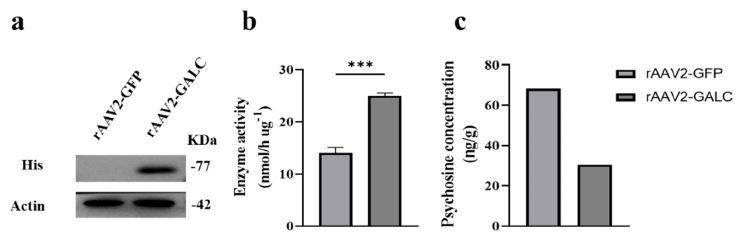
Figure 3. rAAV2-mediated GALC delivery to K-NSCs with high efficiency. ( a ): Western blot analysis of infected K-NSCs with antibodies against His (tagged with GALC) and actin. ( b ): rAAV2-GALC virus rescued the GALC enzyme activity of K-NSCs. Data are expressed as the mean ± SD (n = 4). *** p < 0.001. ( c ): rAAV2-GALC virus decreased accumulation of the GALC substrate psychosine in K-NSCs.